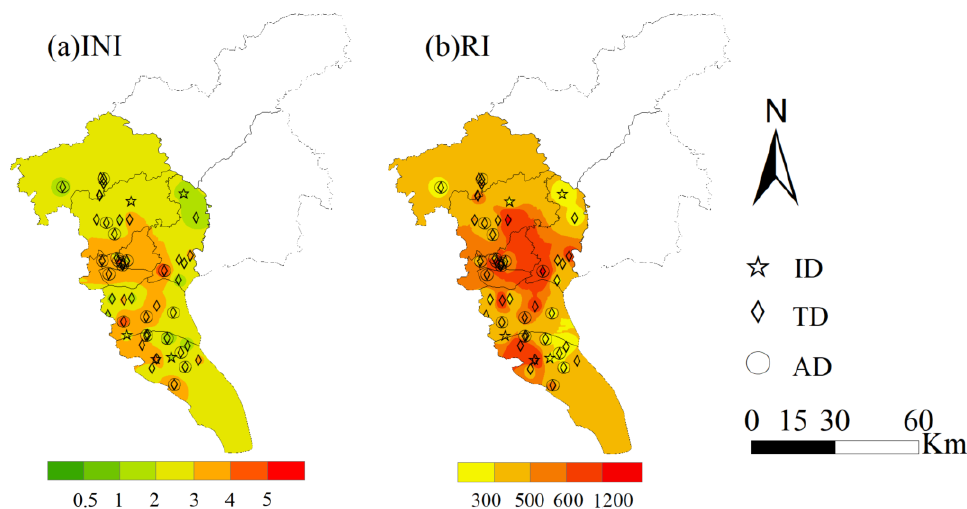
Figure 3. Spatial distribution for the improved Nemerow index (INI) and ecological risk index (RI) for the trace metals in the road dust from the industrial park (ID), traffic intersection (TD), and agricultural field (AD) areas of Guangzhou.